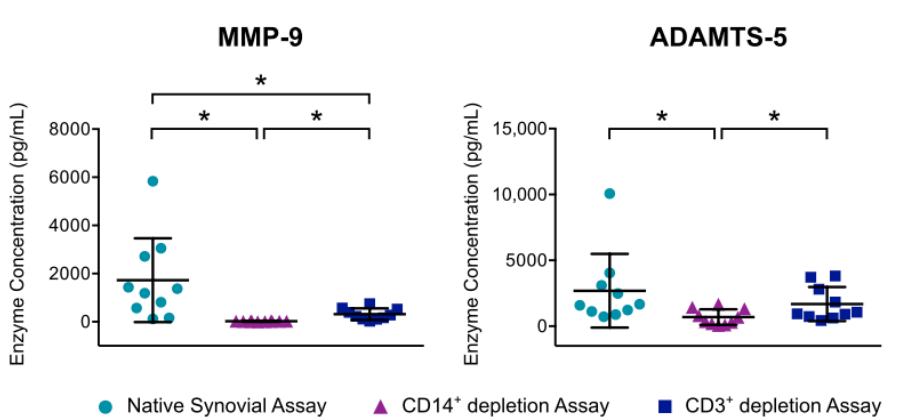
Figure 5. Effect of mononuclear cell depletion on MMP and ADAMTS production of synovial cell cultures is shown. After enzymatic digestion of synovial membrane from patients with advanced knee OA, depletion of CD14 + macrophages and CD3 + T cells was performed using magnetic activated cell sorting. Cells of native synovial assays and depletion assays were cultured for 12 h at 37 °C and 5% CO 2 . Enzyme linked immunosorbent assays were then used to analyze enzyme production in culture supernatants. Mean and standard deviation of enzyme concentrations of MMP-1 / -3 / -9 and ADAMTS-5 are plotted ( n = 7). Significant di ff erences are indicated by asterisks: * p < 0.05. In addition, production of MMP-13, ADAMTS-5 and ADAMTS-7 were analyzed, but concentrations were below detection level.